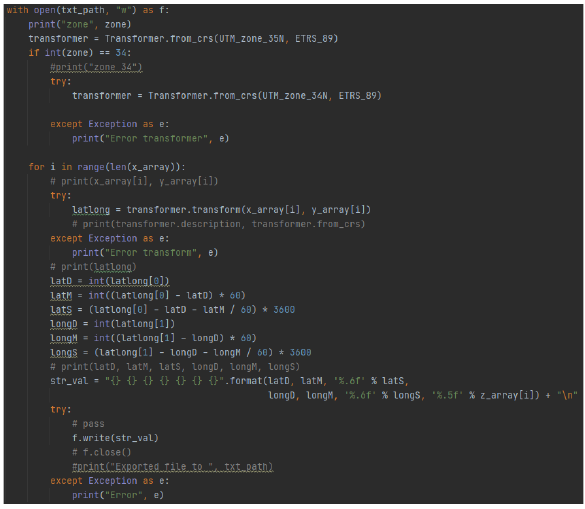
Figure 2 . UTM to ETRS89 conversion using pyproj